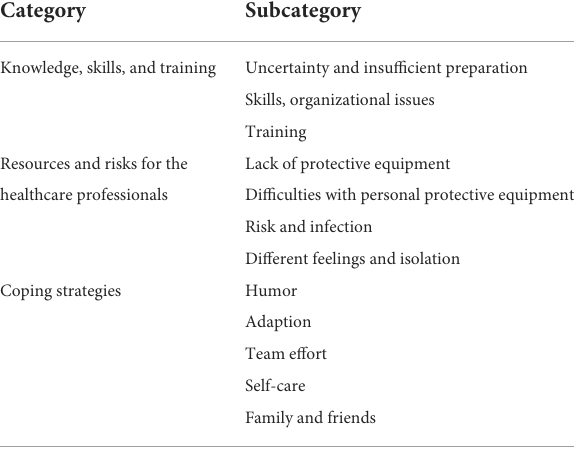
TABLE 3 Categories and